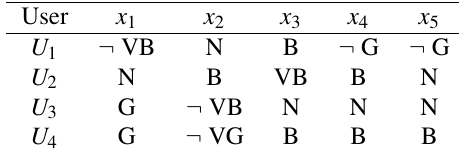
Table 2. User Evaluation